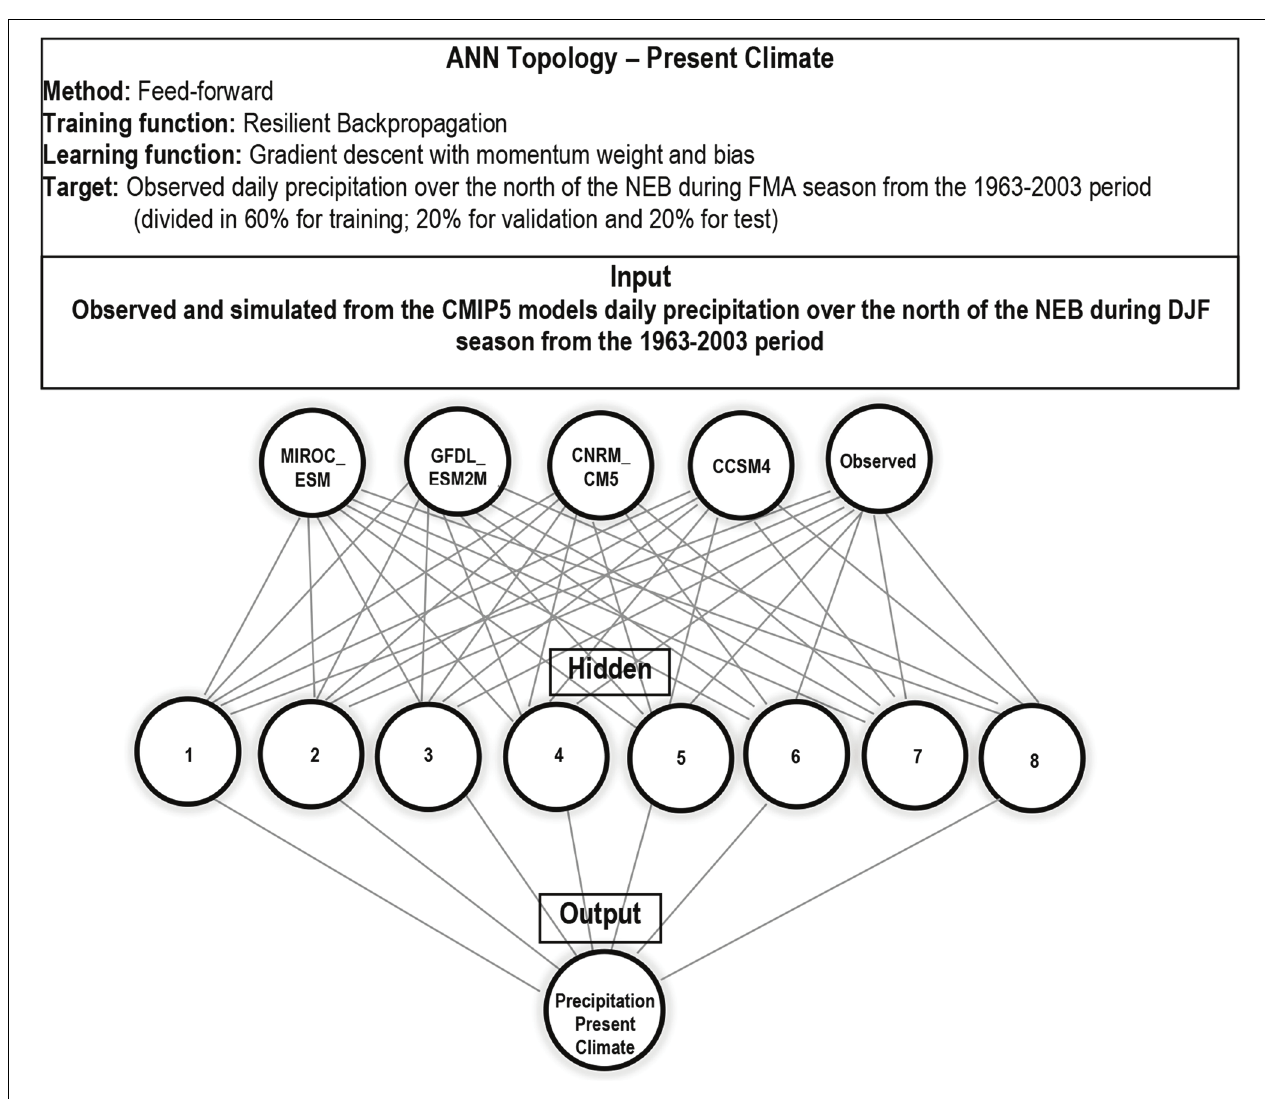
FIGURE 2 | ANN topology used for the present climate